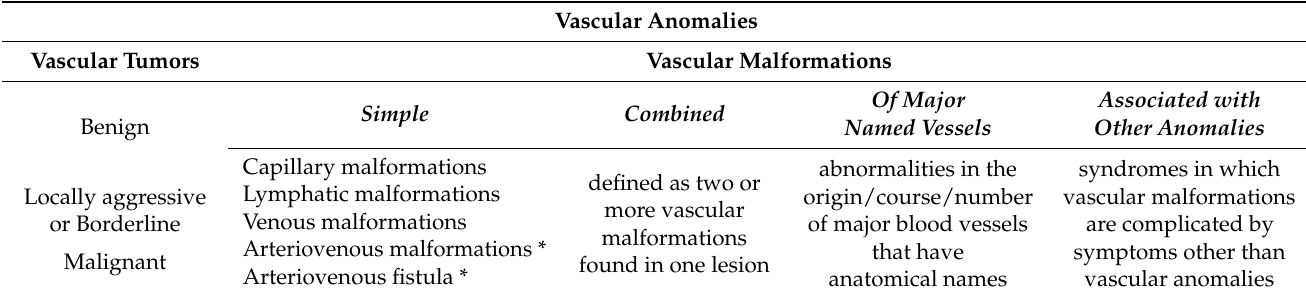
Table 1. Overview table of ISSVA classification 2018, modified Table in Ref.